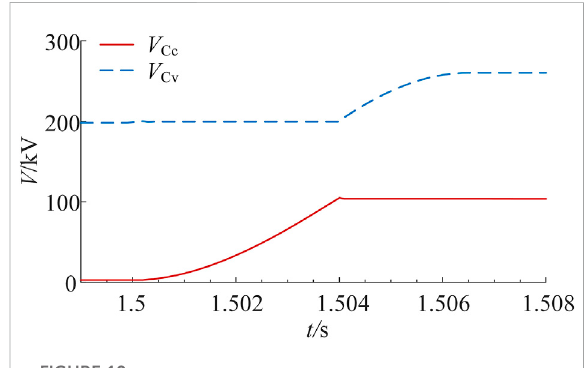
FIGURE 10 Current limiting capacitor and sink capacitor voltage curves.